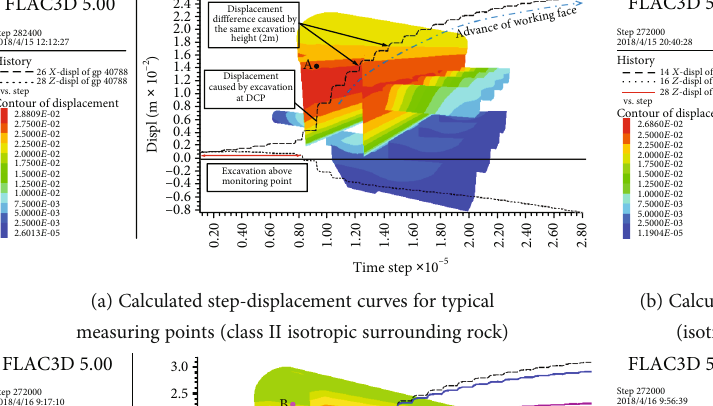
(b) Calculated step-displacement curves for typical measuring points (isotropic surrounding rock excavation and timely support)